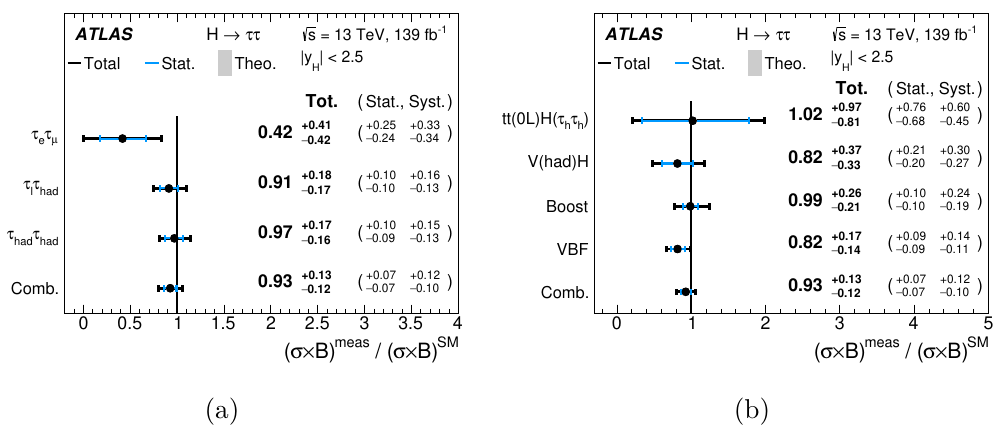
Figure 12. The measured values for σ × B ( H → ττ ) relative to the SM expectations when only H the data of (a) individual channels or (b) individual categories are used. The total ± 1 σ uncertainty in the measurement is indicated by the black error bars, with the individual contribution from the statistical uncertainty in blue. The results have been extracted performing a fit for the inclusive cross-section measurement.